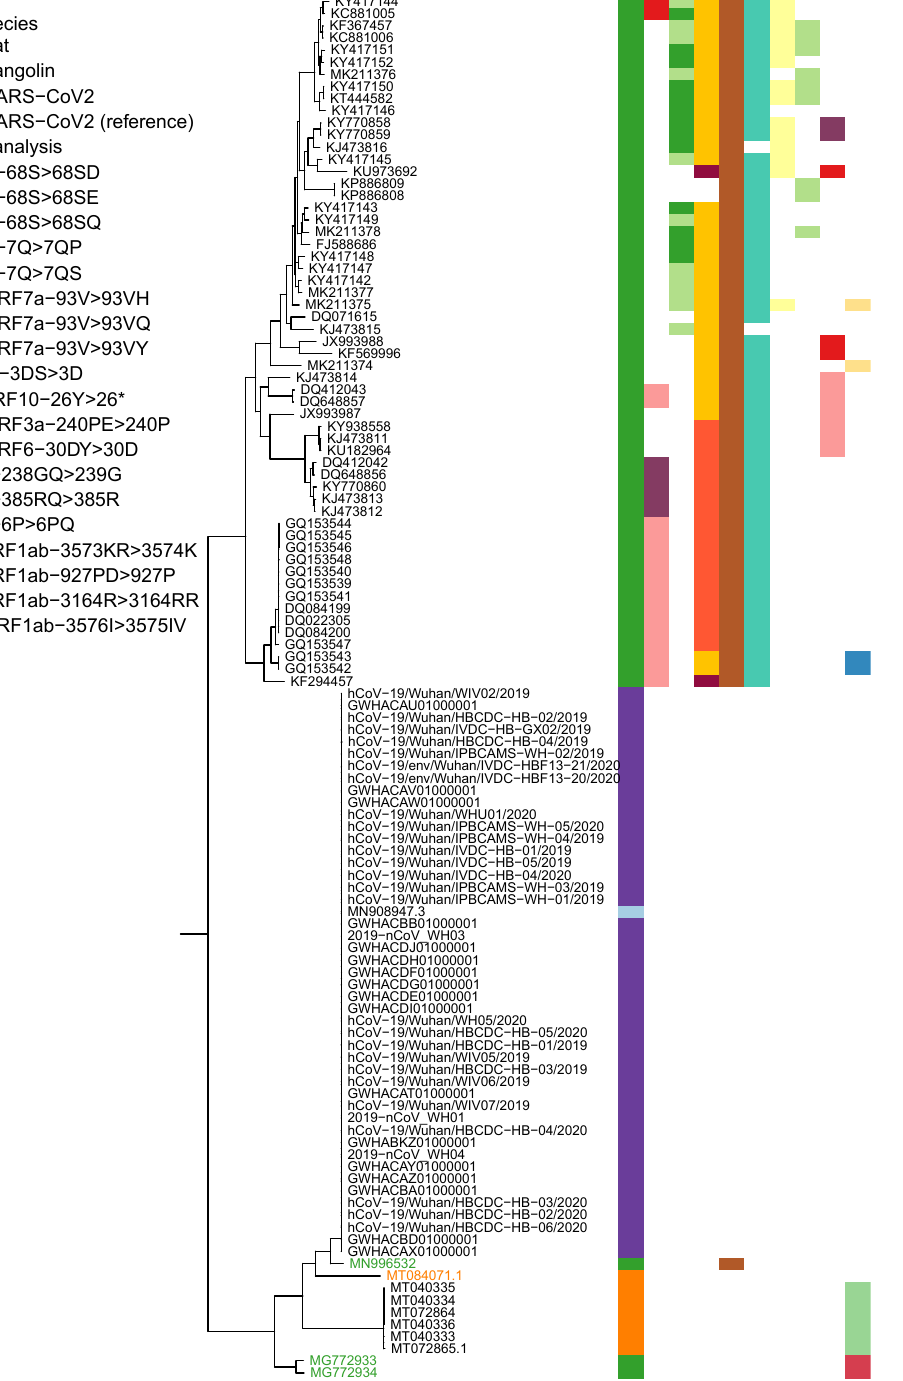
Figure 1. Phylogenetic tree showing relationship between bat-CoV, pangolin-CoV and SARS-CoV-2. This is the Sarbecovirus clade from Figure A5, the phylogenetic tree made with all bat-CoV, all pangolin-CoV and SARS-CoV-2 (Wuhan dataset and SARS-CoV-2 reference) used in this study. Along with the (a) host organisms, results from the variant analysis are annotated, showing (b–d) positions with multiple amino acid changes, (e–h) positions with a single amino acid change (in >10 genomes) and (i,j) other variants. The genes and amino acid changes involved in each of the annotated inframe insertion, inframe deletion or stop gain (*) are indicated in the figure legend. The names of four genomes are highlighted, including 3 bat-CoV—MN996532 (bat-RaTG13), MG772933 (bat-SL-CoVZC45) and MG772934 (bat-SL-CoVZXC21)—and 1 pangolin-CoV, MT084071.1 (pangolin-MP789), as they are more closely related to SARS-CoV-2 than the other bat-CoV or pangolin-CoV in the